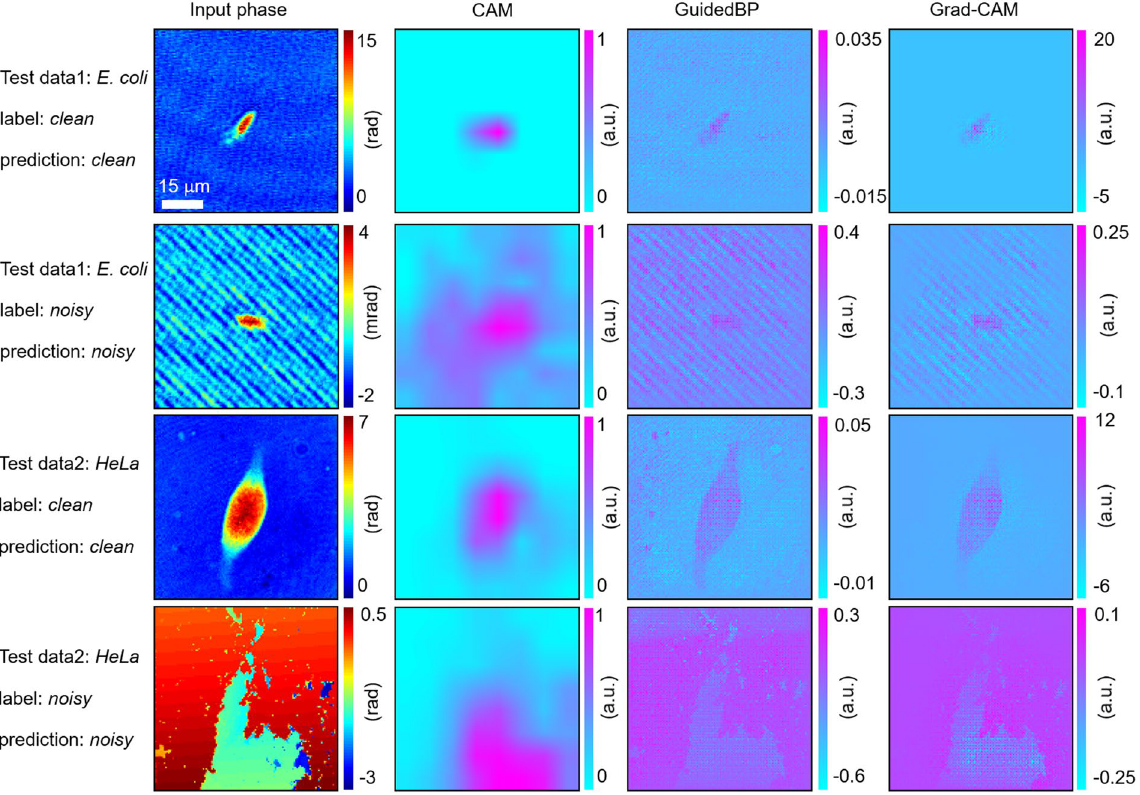
Figure 6. Visual interpretations of the deep network inference. For each class (clean and noisy) of the phase image for E . coli and NIH3T3 (column 1), we extracted a class activation mapping image (CAM) (column 2), guided back-propagation (GuidedBP) (column 3), and gradient-weighted class activation mapping (Grad- CAM) (column 4). Among the three visualization techniques, the Grad-CAM images, generated from the point-wise product of CAM and guided BP, best display the anatomical region that our deep neural network might have utilized for its